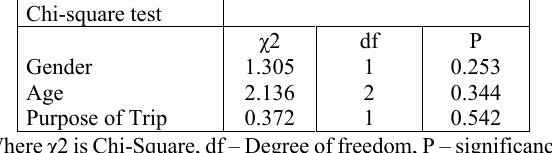
Table 6 . Chi-square test of Age, Gender, and Trip purpose.